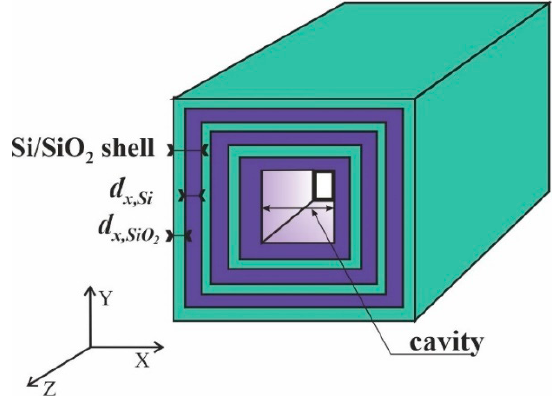
Figure 1. Scheme of a Si/SiO 2 rectangular MNT.